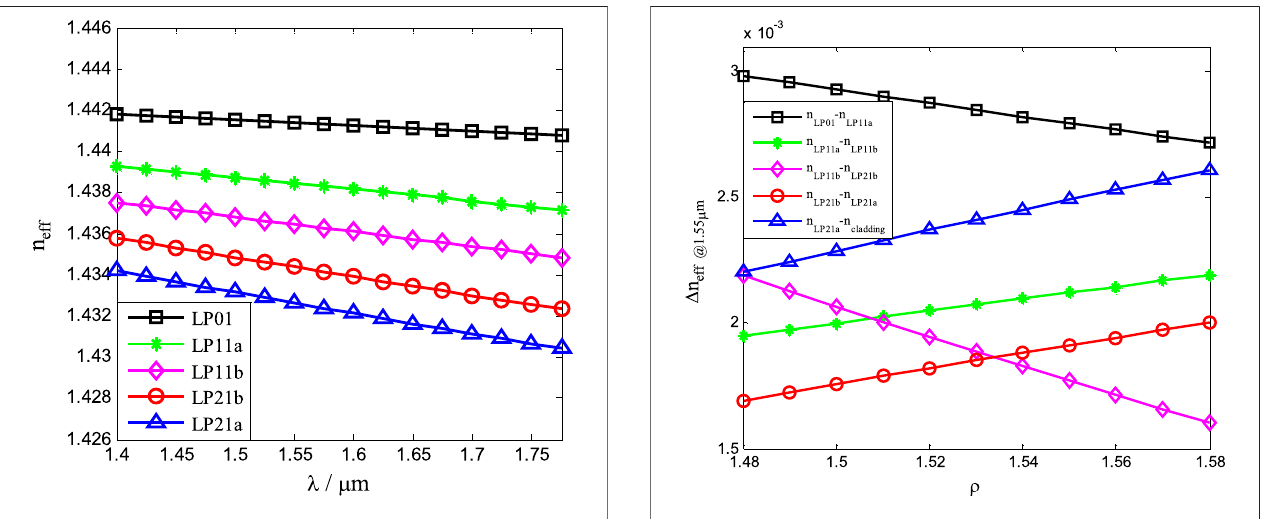
FIGURE 4 | Variations of effective refractive index differences with the ellipticity. The solid lines with squares, stars, diamonds, circles, and triangles represent the effective refractive index differences between the modes LP01 and LP11a, LP11a and LP11b, LP11b and LP21b, LP21b and LP21a, and LP21a and cladding,